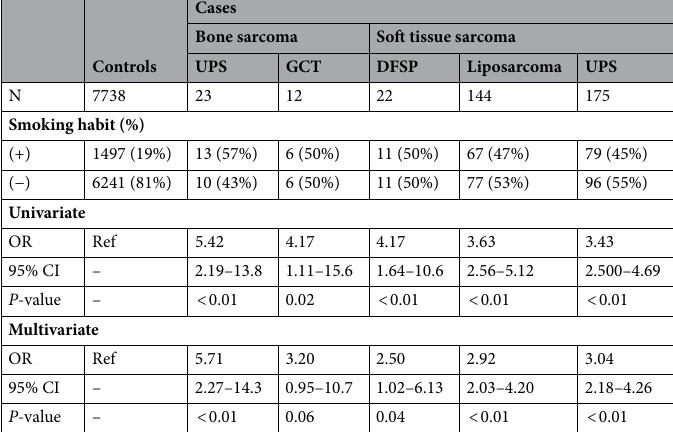
Table 6. Smoking rates in patients ≥ 20 years of age according to histological subtypes of sarcoma. Ref reference, UPS Undifferentiated pleomorphic sarcoma, GCT Giant cell tumor of bone, DFSP Dermatofibrosarcoma protuberans, OR Odds ratio, CI Confidence interval.